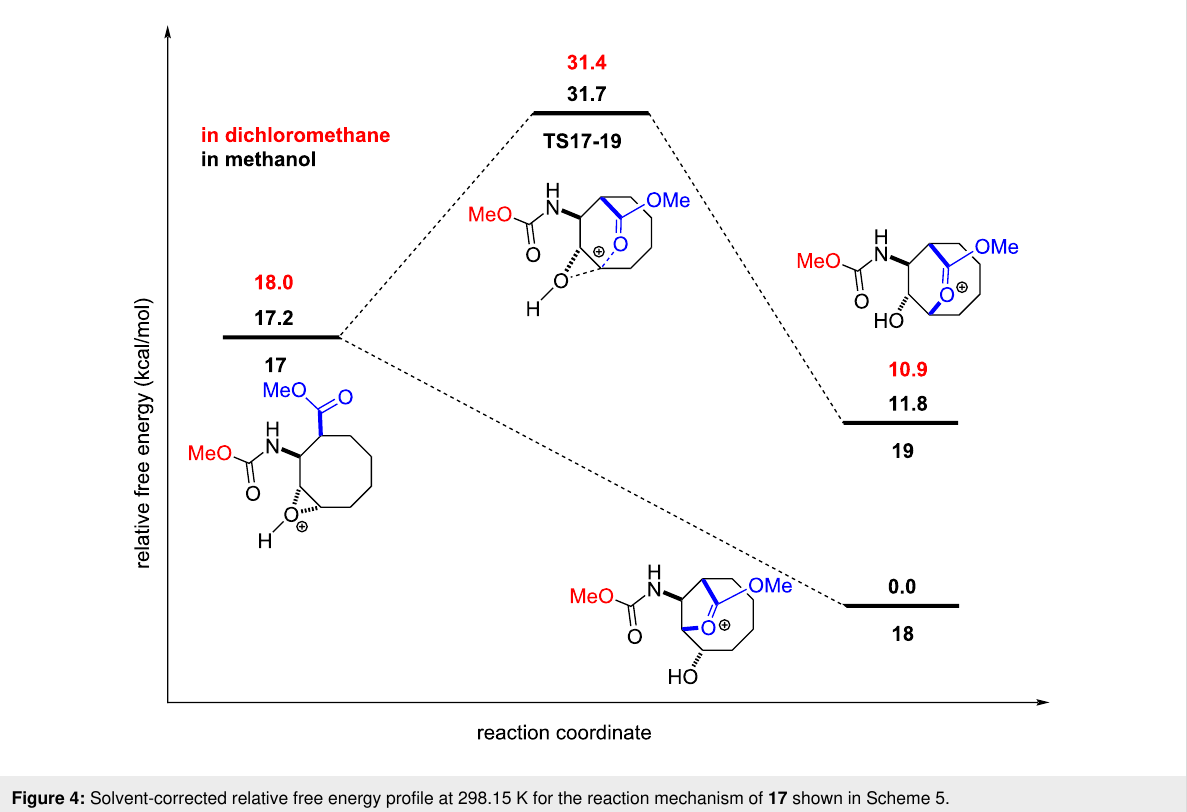
Figure 4: Solvent-corrected relative free energy profile at 298.15 K for the reaction mechanism of 17 shown in Scheme 5.